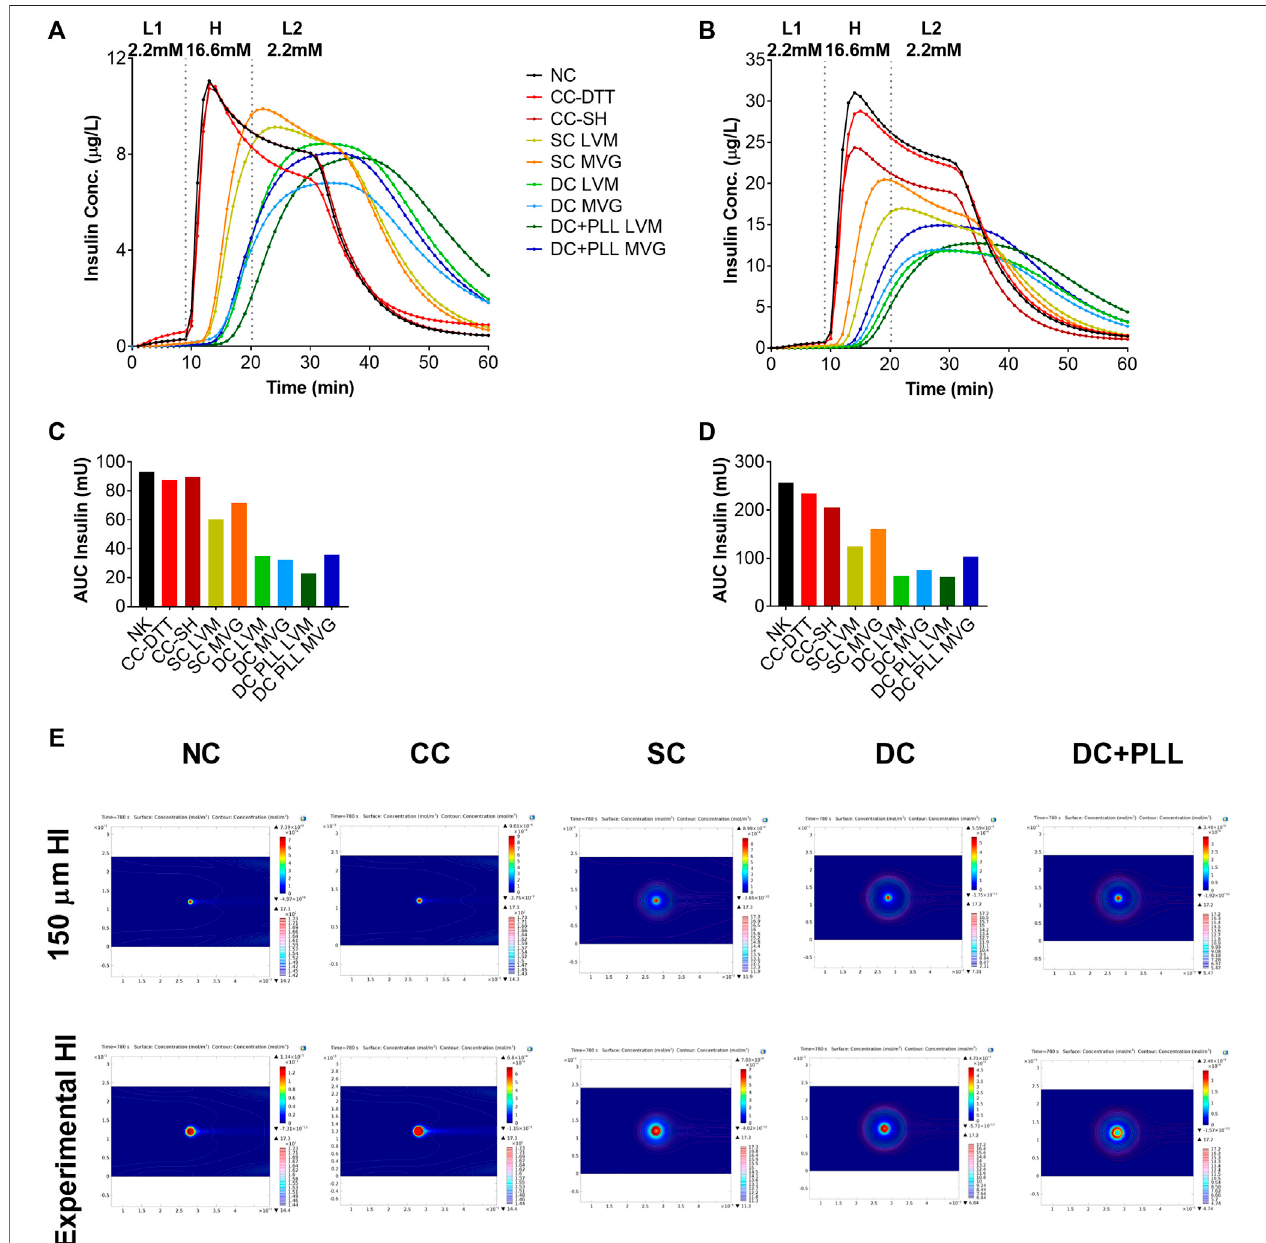
FIGURE 6 | In silico glucose-stimulated insulin response of microencapsulated human islets compared with non-coated islets. (A,B) in silico dynamic GSIS of HIs non-coated (NC, black) or encapsulated in conformal coating (CC, red), single MVG capsules (SC MVG, orange), double MVG capsules with and without PLL (DC MVG PLL,darkblue,andDCMVG,lightblue),singleLVMcapsules(SCLVM,yellow),anddoubleLVMcapsuleswithandwithoutPLL(DCLVMPLL,darkgreen,andDCLVM, light green). Islets were assumed to be perfused for a total of 60 min with 2.2 mM (mol/m3) low (L1) glucose (0 – 9 min) followed by 16.6 mM high (H) glucose (10 – 19 min),andby2.2 mMlow(L2)glucose(20 – 60 min)asindicated.Simulationswereperformedusingthe150 µmstandardisletsize (A) aswellastheexperimentally measuredaveragediametersofisletshere( Table1 ) (B) . (C,D) Quanti fi cationoftotalunitsofinsulinreleasedasAUCofcalculatedinsulinreleasepro fi lesshowninpanels (A,B) . € Concentrations of insulin and glucose of NC and encapsulated HIs at 780 s (time of highest peak of insulin released from NC control) shown as colored surface and contour plots, respectively (E)